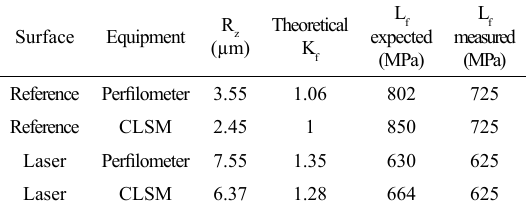
Table 2. Summary of the fatigue test results and